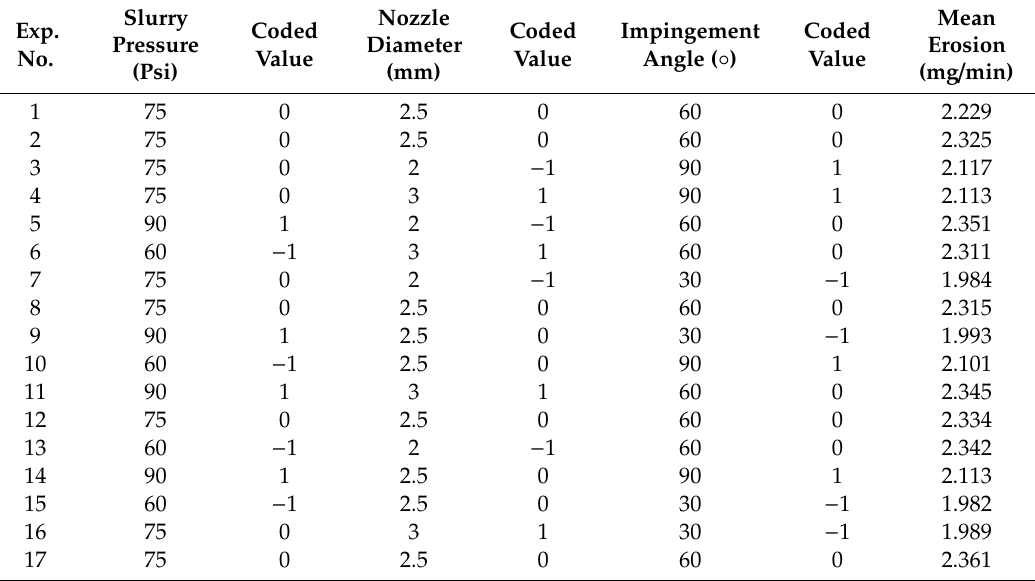
Table 2. Controllable parameters and